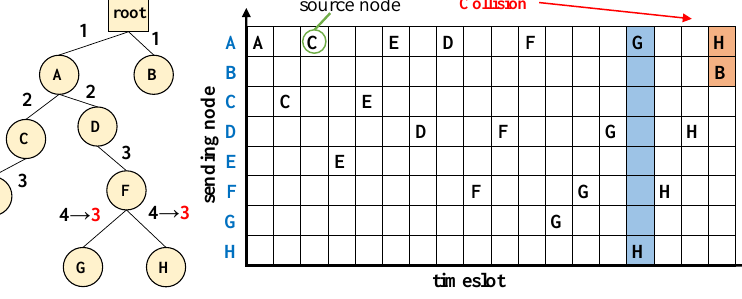
Figure 4. An example of parallel transmission